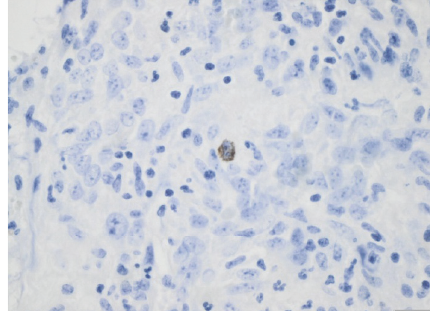
Figure 2: Submucosa [ × 60]. Red-brown staining was regarded as a positive